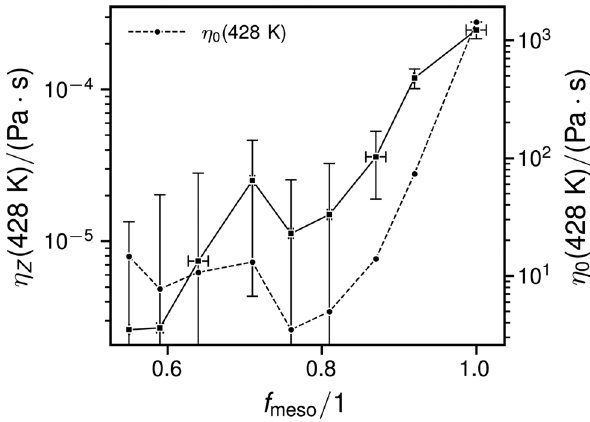
, squares and full lines, by Z , circles and 0